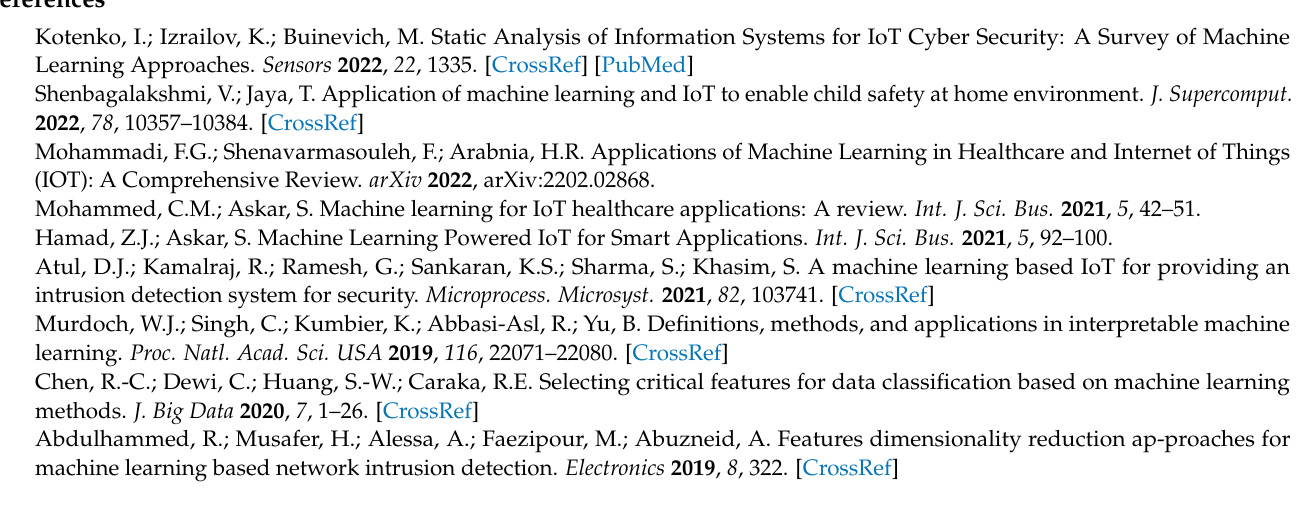
Figure A8. The comparison of the model size on the disk and the comparison of the model size on the disk after the application of the zip function.